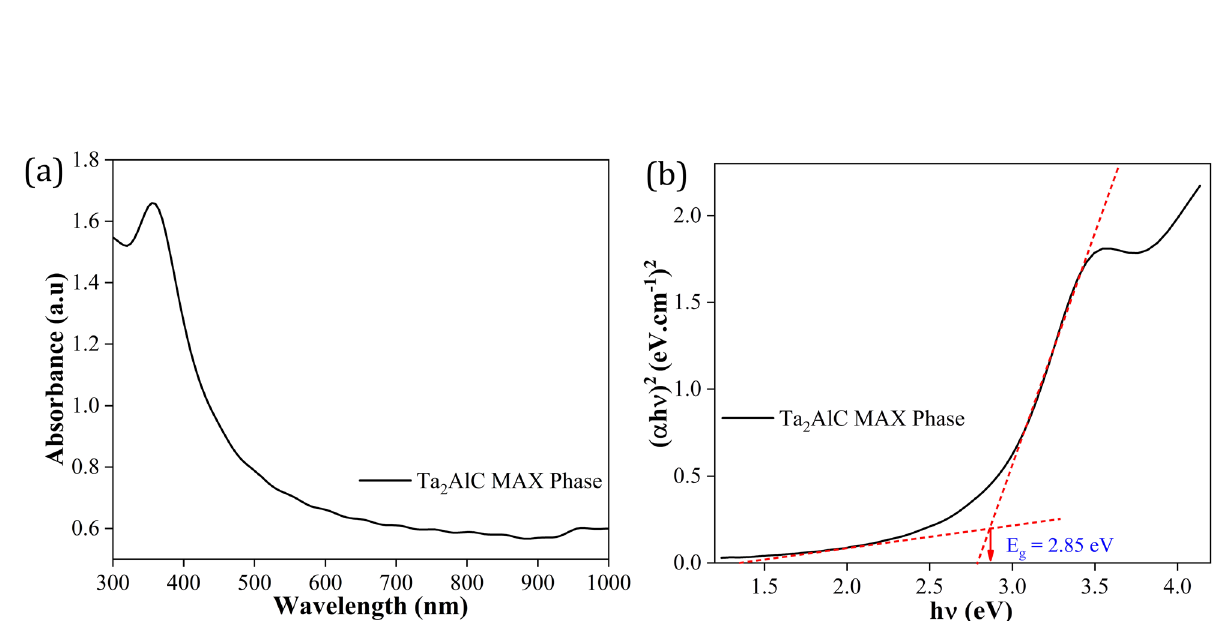
Figure 3. ( a ) UV–Vis absorbance spectrum of Ta 2 AlC MAX Phase and ( b ) corresponding Tauc plot for bandgap